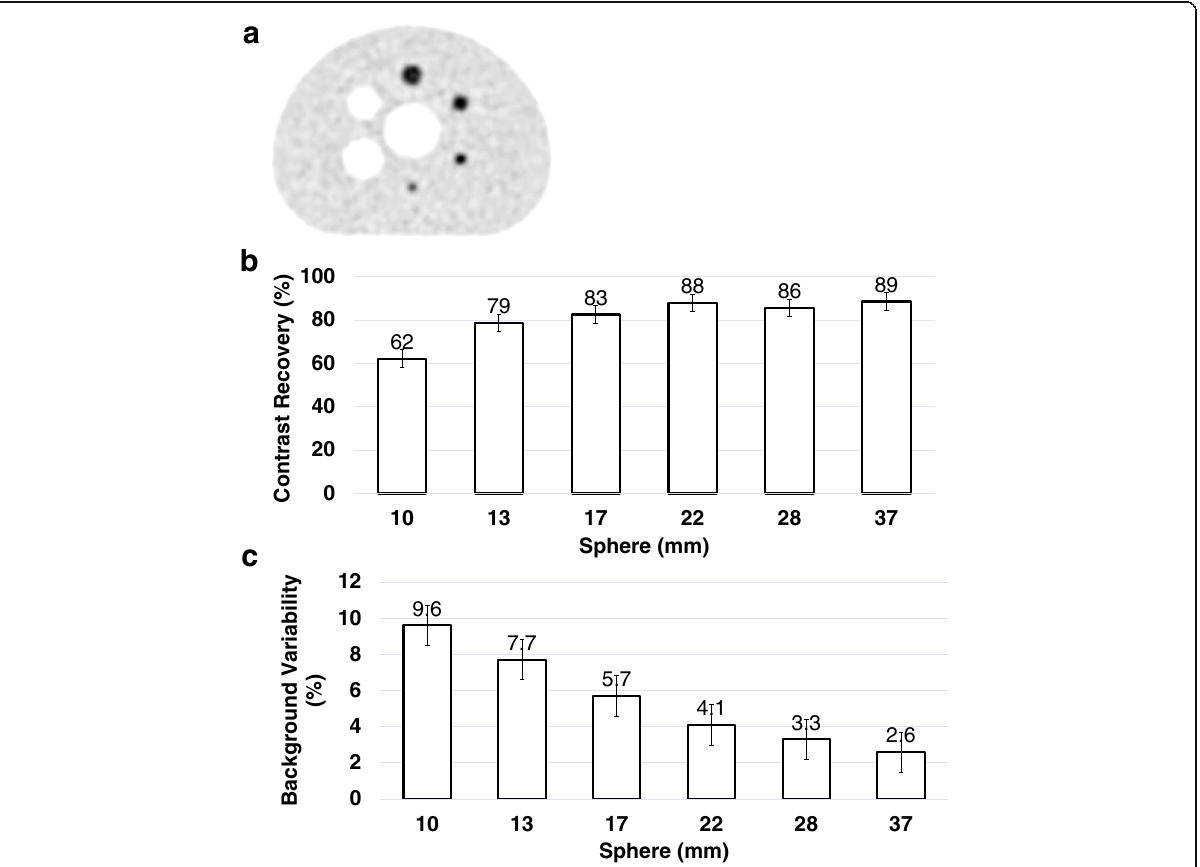
Fig. 6 NEMA NU2-2012 image quality of the IEC body phantom PET reconstructed using 3D OSEM TOF PSF. a PET image ( b and c ), assessment of contrast recovery, and background variability, respectively. The average lung error was 4.18 ±